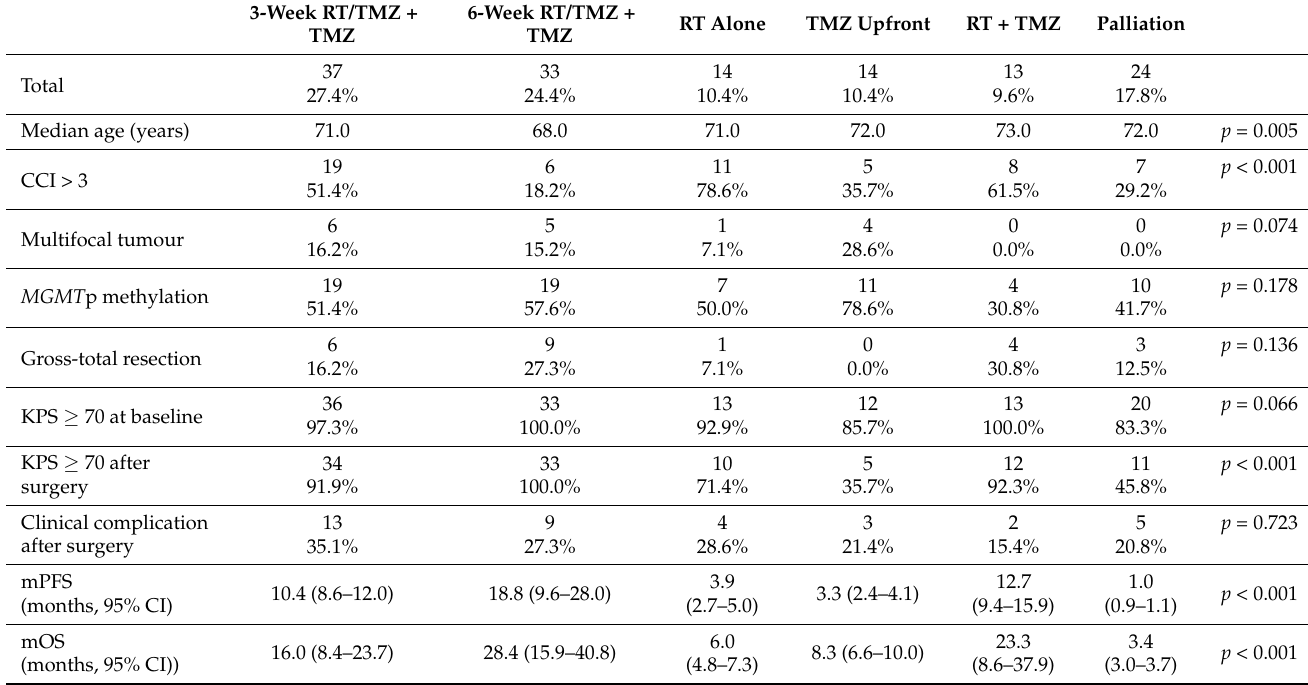
Table 4. Characteristics of patients within different groups of